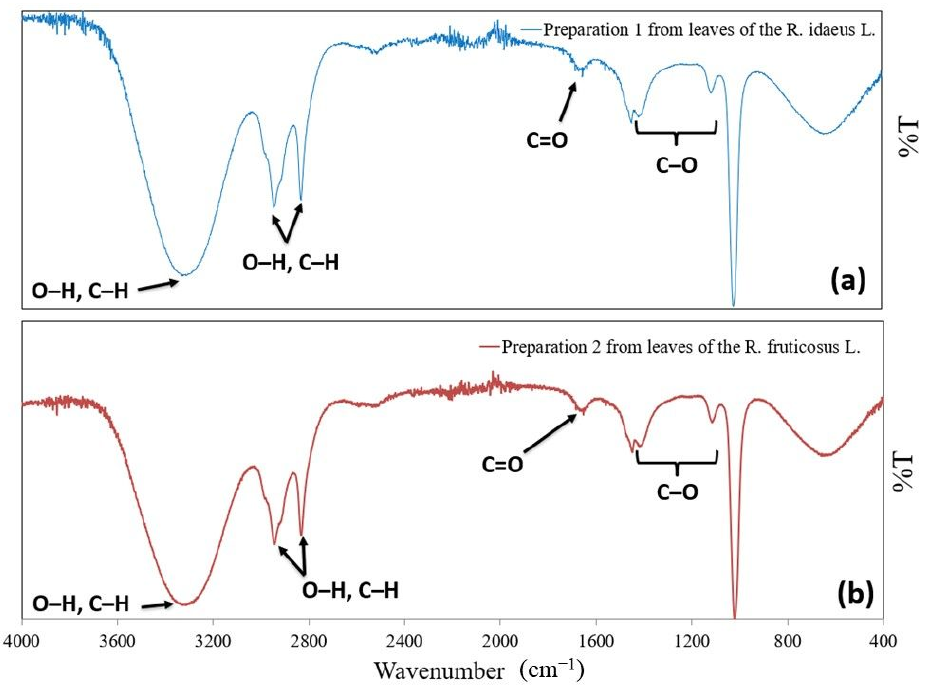
Figure 1. ATR ‐ FTIR absorption spectra of ( a ) preparation 1 obtained from the leaves of R. idaeus L. and ( b ) preparation 2 obtained from the leaves of R. fruticosus L.